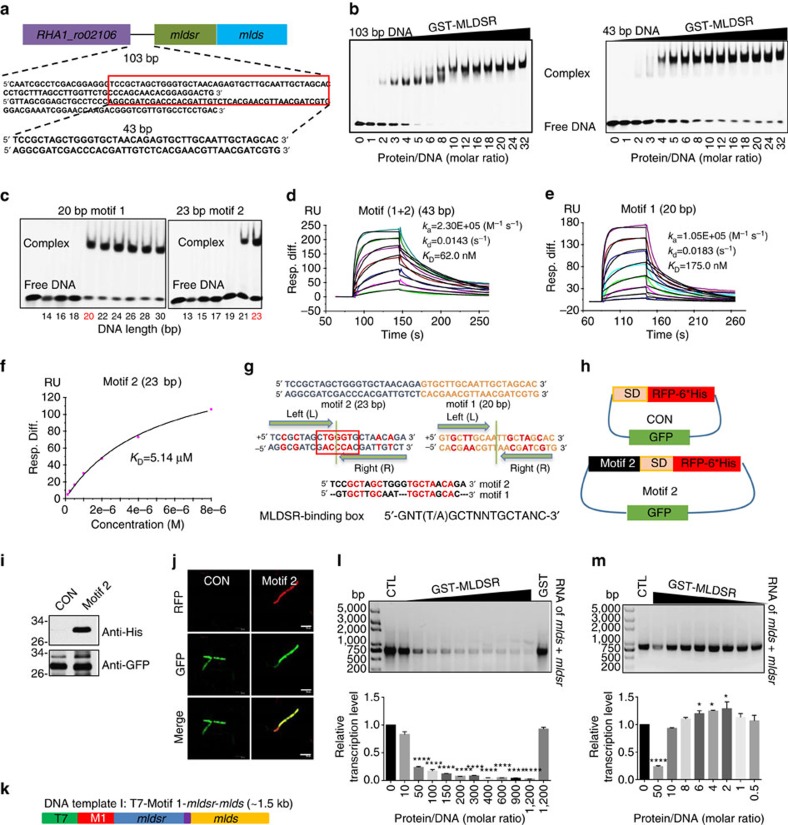
MLDSR regulates MLDS expression by binding the promoter and operator of their operon.(a) Schematic showing DNA motif for MLDSR binding and that mlds and mldsr are in the same operon. (b) EMSAs of MLDSR binding the 103 bp and 43 bp DNA motif. (c) EMSAs of MLDSR binding 20 bp (motif 1) and 23 bp (motif 2). (d–f) SPR analysis for MLDSR binding 43 bp (motif (1+2)) (d) 20 bp (motif 1) (e) and 23 bp (motif 2) (f). Kinetic analysis and steady state affinity were used in the assays, respectively. (g) (top) Schematic showing 43 bp DNA consisting of motif 2 and motif 1. (middle) Motif 2 and motif 1 are palindromic sequences. The key base pairs in the two motifs are shown in red. Motif 2 is similar with T7, T3 and SP6 promoters (shown in red frame). (bottom) The palindromic MLDSR-binding box is shown. (h) Sketch of two plasmids in promoter expression assay. (i) Western blotting of CON and Motif 2 strains using anti-His and anti-GFP. (j) Confocal microscopy images of control and motif 2 strains. Scale bar, 5 μm. (k–m) In vitro transcription assays. (k) Sketch of DNA template. The in vitro transcription assay using DNA template I under high protein/DNA ratio (>50:1) (l) or low protein/DNA ratio (<10:1) (m). CTL represents no MLDSR in reaction and GST represents GST, but not GST-MLDSR in reaction. RNA was detected by EB stained agarose gel (top). Quantification was performed using Image J software (bottom). Data represent mean±s.e.m., n=3. *P<0.05, ***P<0.001, ****P<0.0001, two-way ANOVA.